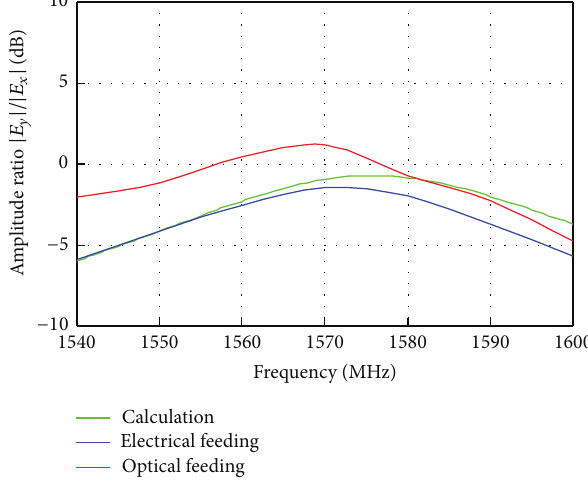
Figure 15: Amplitude ratio for CP patch antenna.